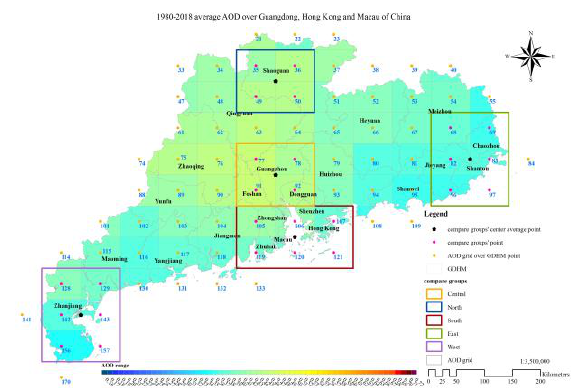
Figure 5. 1980 – 2018 average AOD spatial distribution. The map is produced by Kuang using ArcMap 10.5.